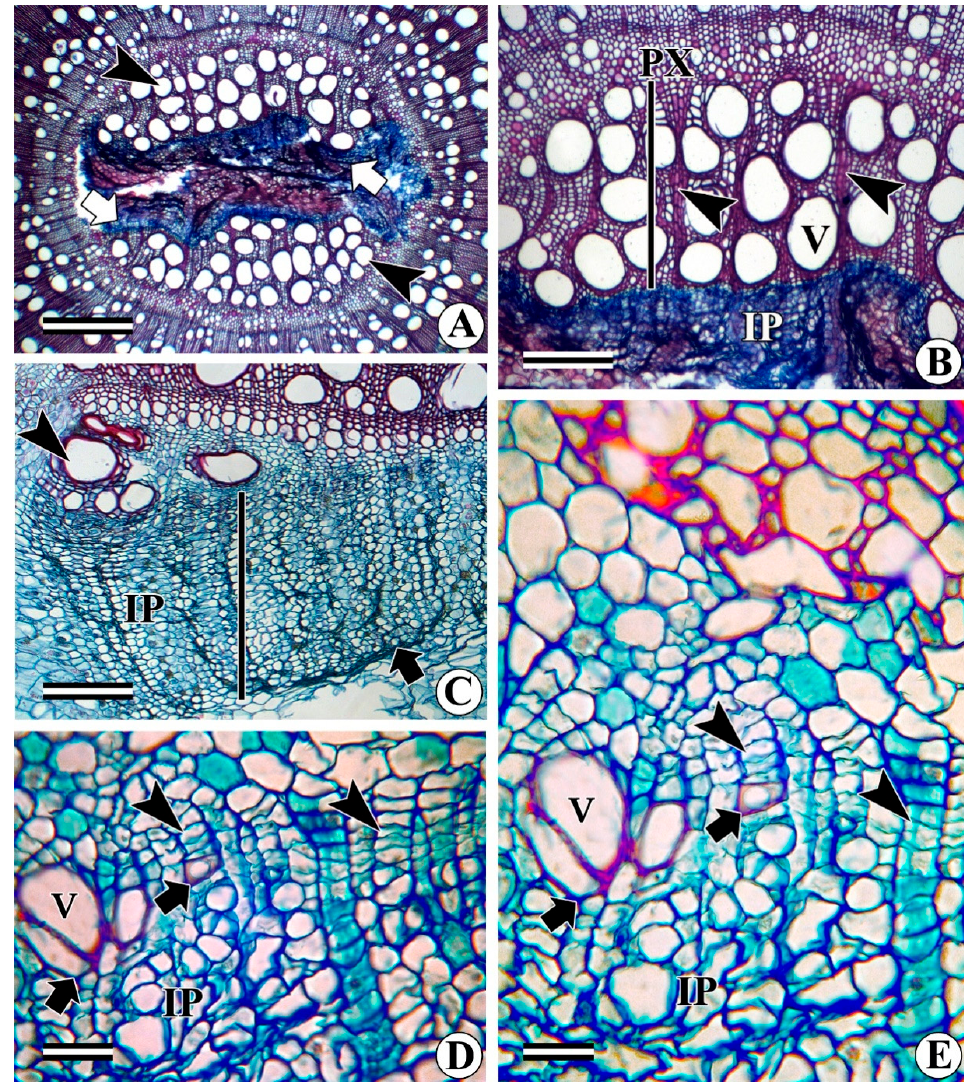
Figure 11. Intraxylary phloem cambium and its products in different species of eudicots. ( A ) Bidirectional activity of the intraxylary phloem cambium that deposits a measurable quantity of secondary xylem (arrowheads) and phloem (arrows). Note that the pith is completely occupied by its products in. ( B ) Enlarged view of Figure 11A showing the structure of the xylem formed by intraxylary phloem cambium. The vertical line indicates the quantity of xylem formed by the intraxylary phloem cambium. Arrowheads indicate the ray-like arrangement of parenchyma cells. ( C ) Development of more phloem (IP) than secondary xylem (arrowhead) in Hewittia malabarica by intraxylary phloem cambium. Arrow indicates crushed non-conducting phloem. Note the amount of phloem (vertical bar). ( D ) Unidirectional differentiation of both xylem and phloem by the intraxylary phloem cambium. Note the position of intraxylary phloem cambium (arrowheads), xylem (arrows), and phloem (IP) in Ipomoea turbinata . ( E ) Enlarged view of Figure 11D. Abbreviations: IP = intraxylary phloem, PX = protoxylem, V = vessel. Scale bars : ( A , D , E ) = 500 µ m, ( B , C ) = 200 µ In a real sense, functionally unidirectional intraxylary phloem cambium is referred to as a condition where the secondary xylem and phloem are deposited in the same di- rection [128,133]. The formation of secondary xylem and phloem by the intraxylary phloem cambium in the same direction has so far only been reported in Hoya carnosa and Marsdenia tomentosa by Handa [133] and in Ipomoea turbinata by Rajput and Gondaliya